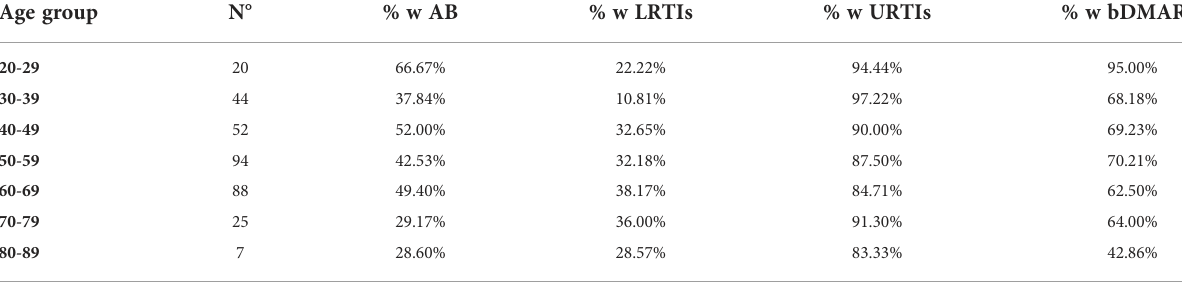
TABLE 4 Strati fi cation of antibiotic therapy and infections by age group.